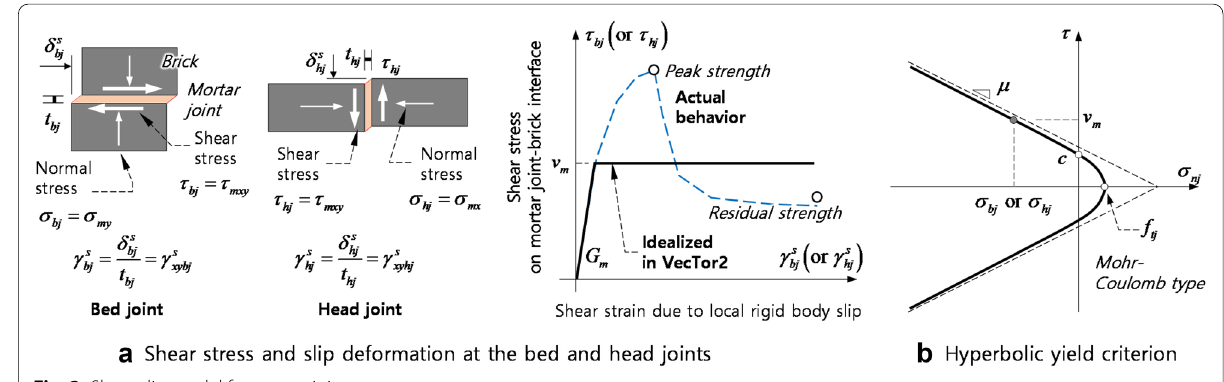
Fig. 3 Shear slip model for mortar